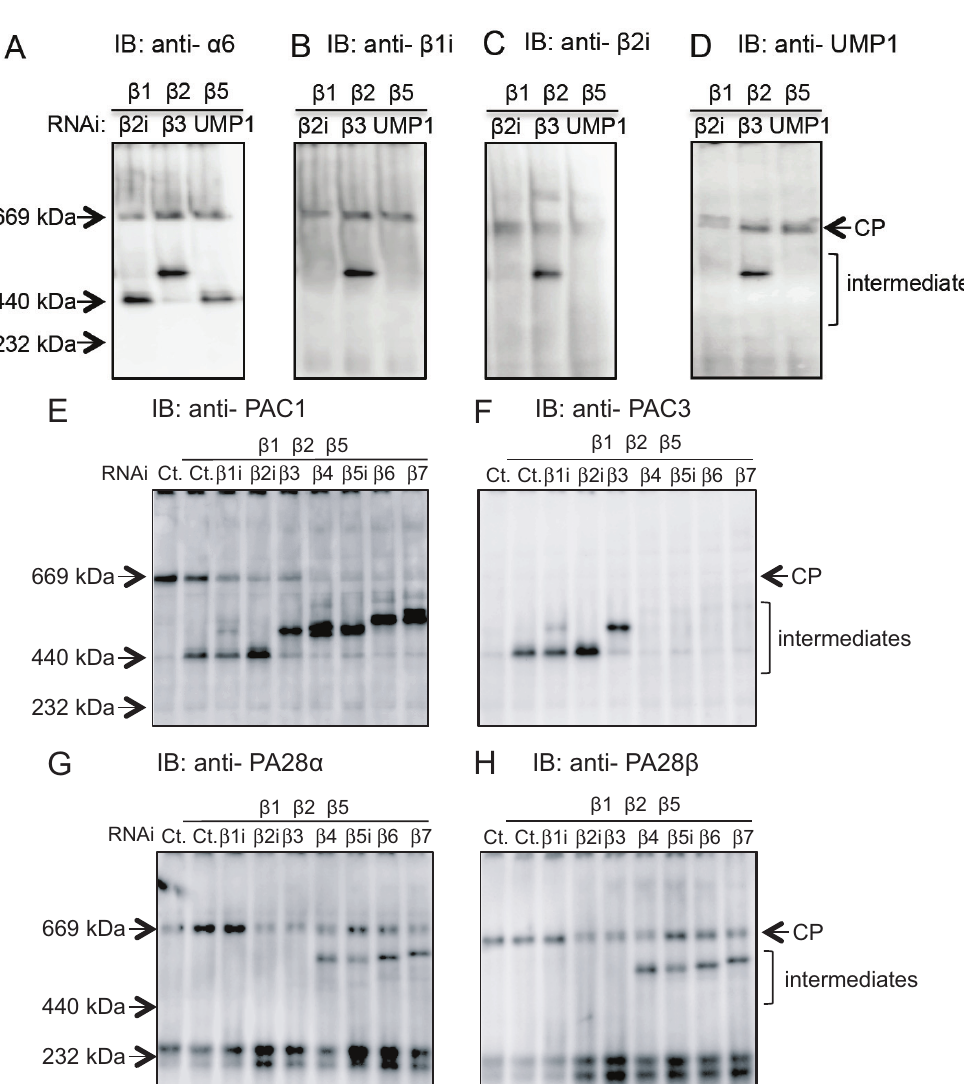
anti-PA28(cid:2) ( H )